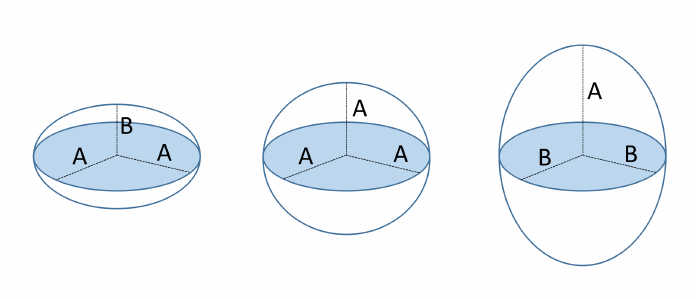
Figure 5. Left : oblate spheroid model; Center : sphere model; Right : prolate spheroid model.